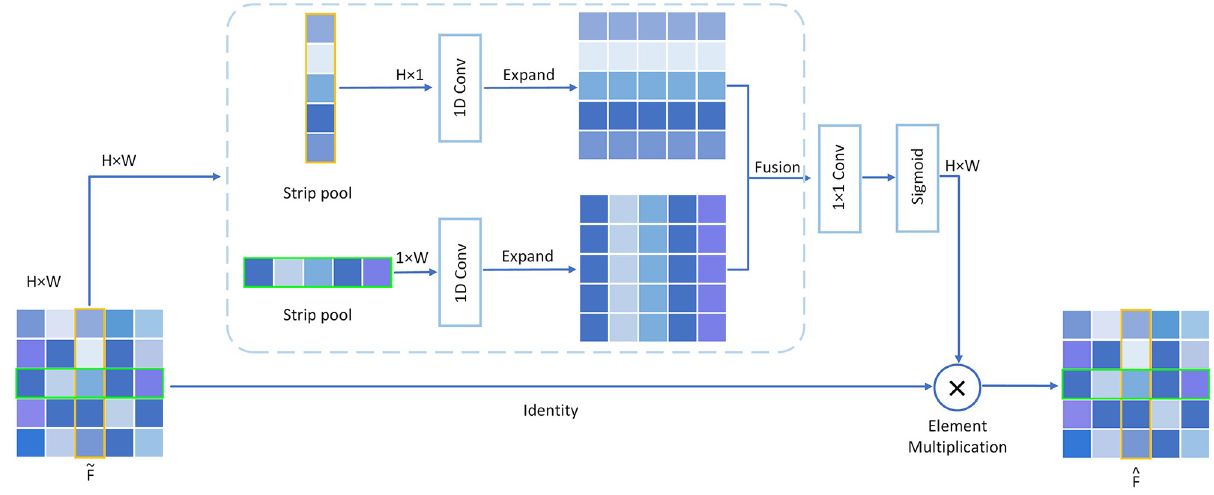
Fig 4. Illustration of strip pooling